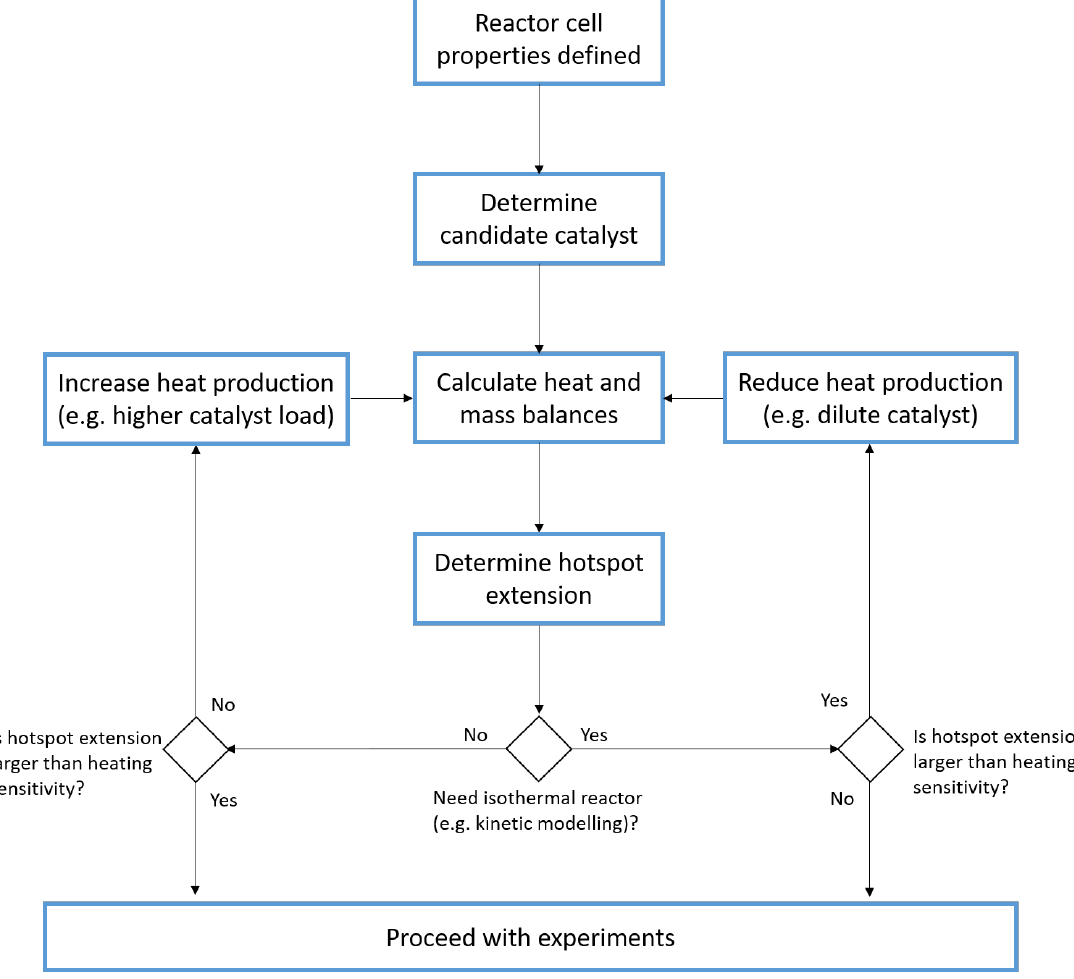
Figure 7. Decision tree for the determination of an appropriate experimental design methodology for IR thermography Figure experiments.